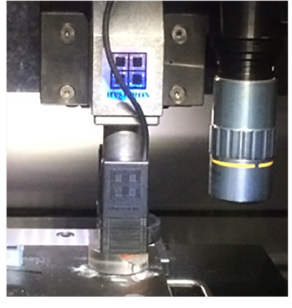
Figure 4. Testing setup.